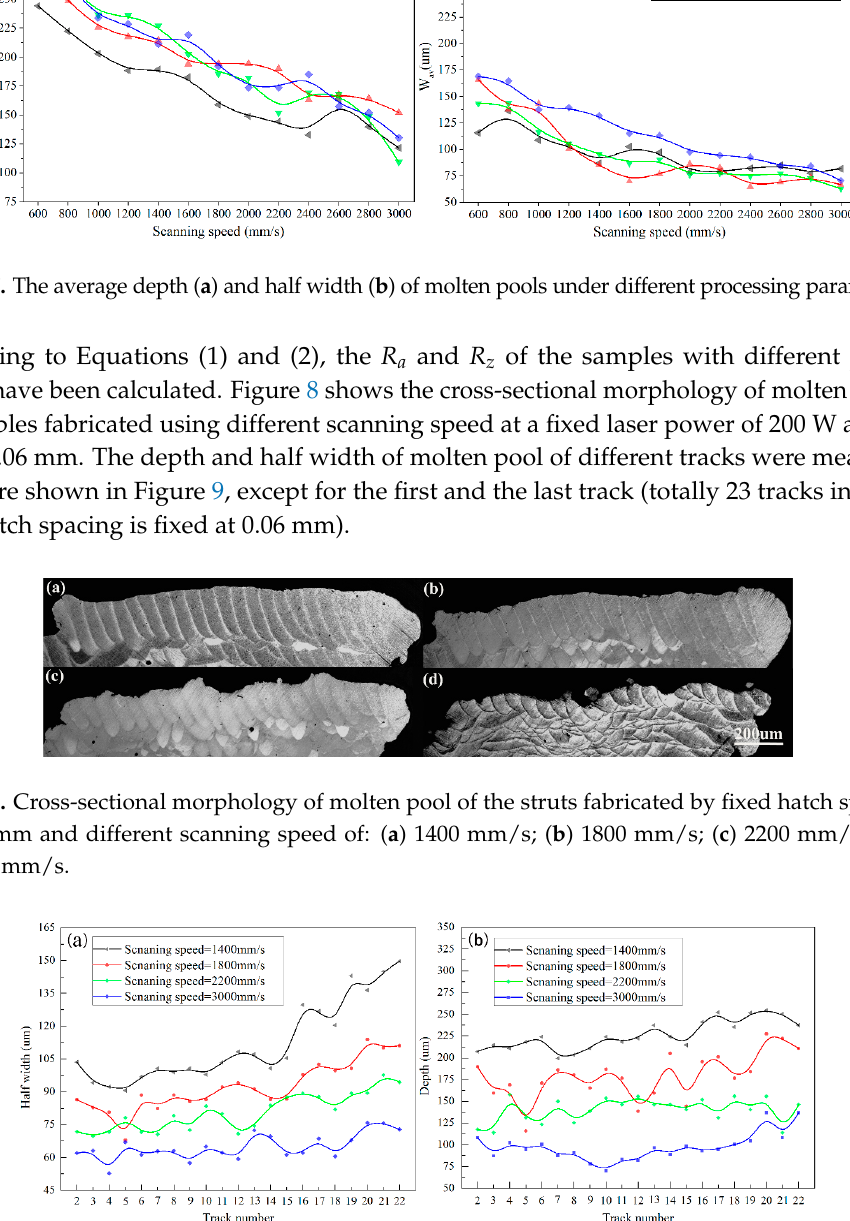
Figure 9. The half width ( a ) and depth ( b ) of molten pool of different tracks.